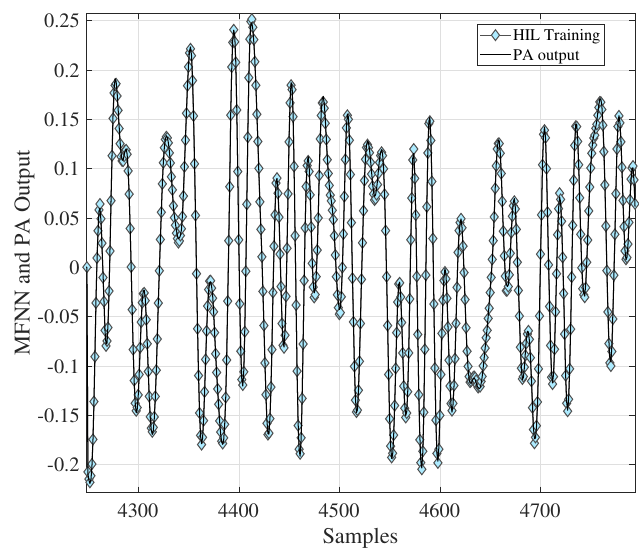
Figure 14. Comparison of results obtained between HIL simulation and PA output.